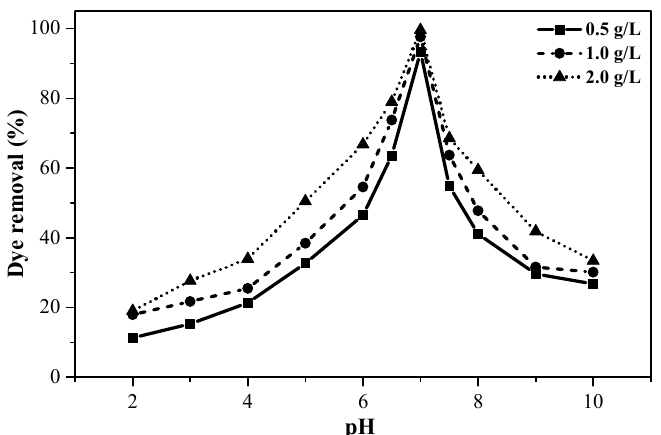
Figure 4. The adsorption of dyes on the banana peel at variable pH’s ( C i = 50 mg/L, M ads = 0.5, 0.75, and 1.0 g, t = 1 h, T = 25 °C, S = 180 rpm, V = 250 mL). and 1.0 g, t = 1 h, T = 25 ◦ C, S = 180 rpm, V = 250